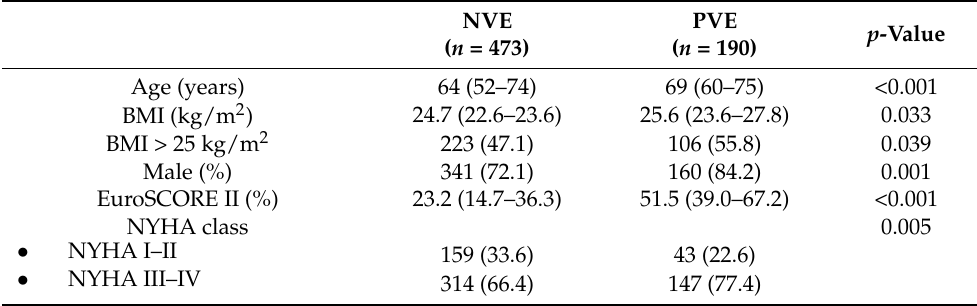
Table 1. Baseline parameters. Data are presented as medians (25–75th percentiles) or absolute left ventricular ejection fraction, and PVE: prosthetic valve